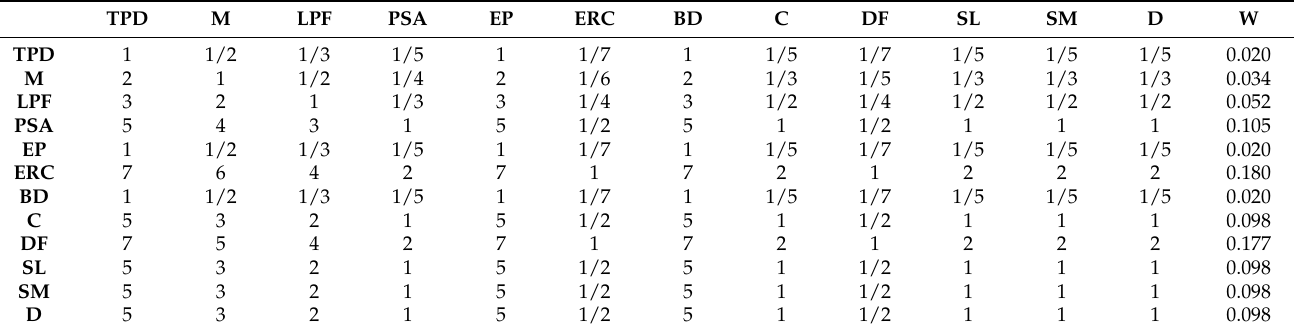
Table 3. The judgment matrix of the evaluation index system of the port